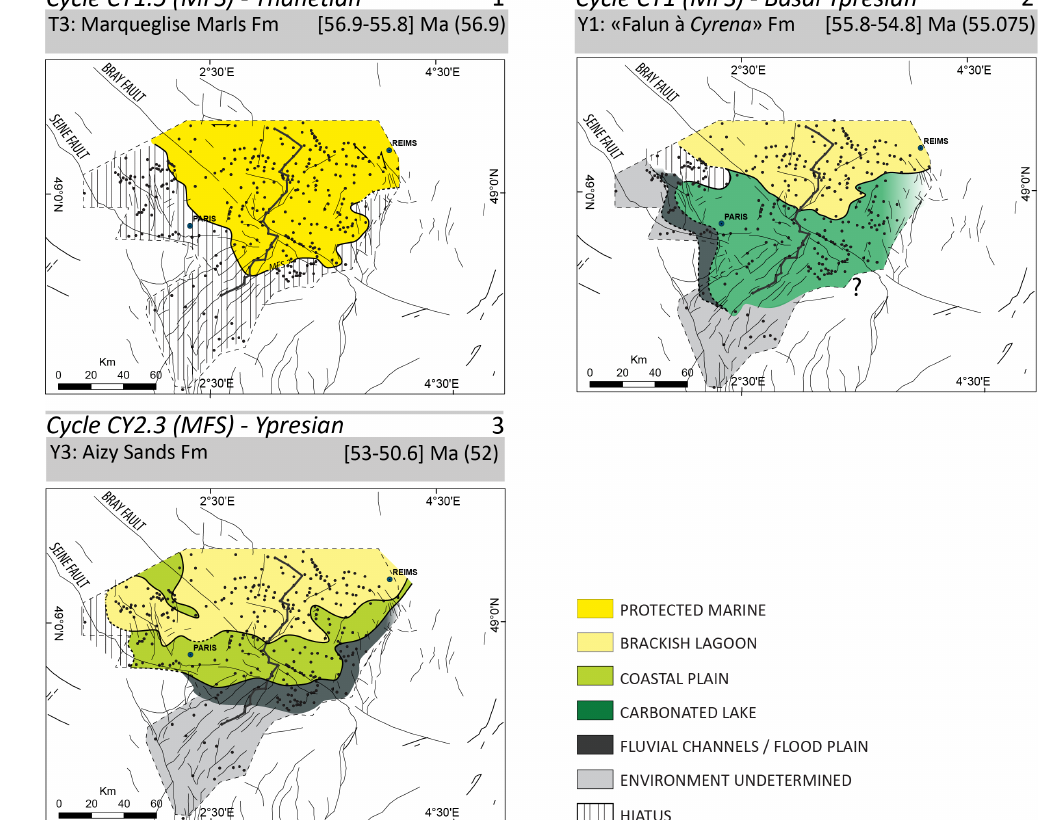
Figure 9. Palaeogeographic (facies) maps for some maximum flooding surfaces of the Thanetian (T3) and Ypresian (Y1 and